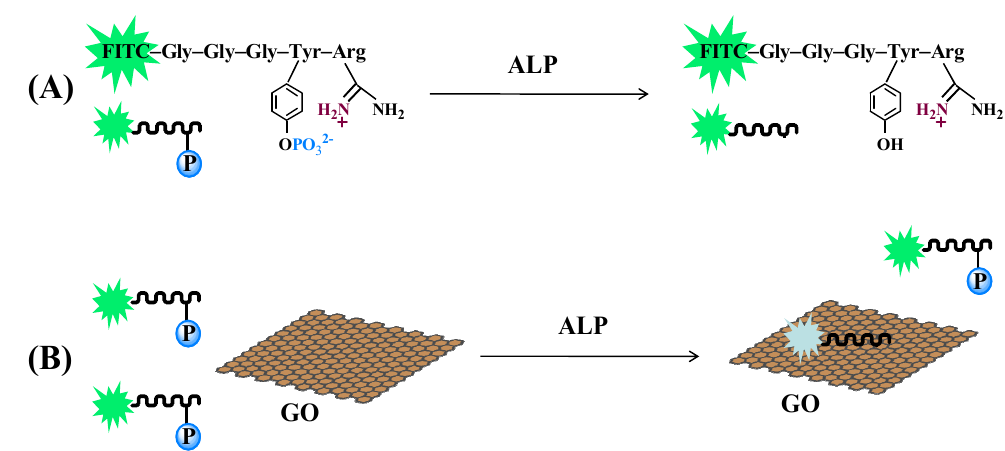
Figure 1. Schematic illustration of dephosphorylation process ( A ) and alkaline phosphatase (ALP) activity detection ( B ) using fluorescein isothiocyanate (FITC)–Gly–Gly–Gly–Tyr(PO 32 − )–Arg (GGGYpR) and graphene oxide (GO) as the probe and the quencher, respectively.